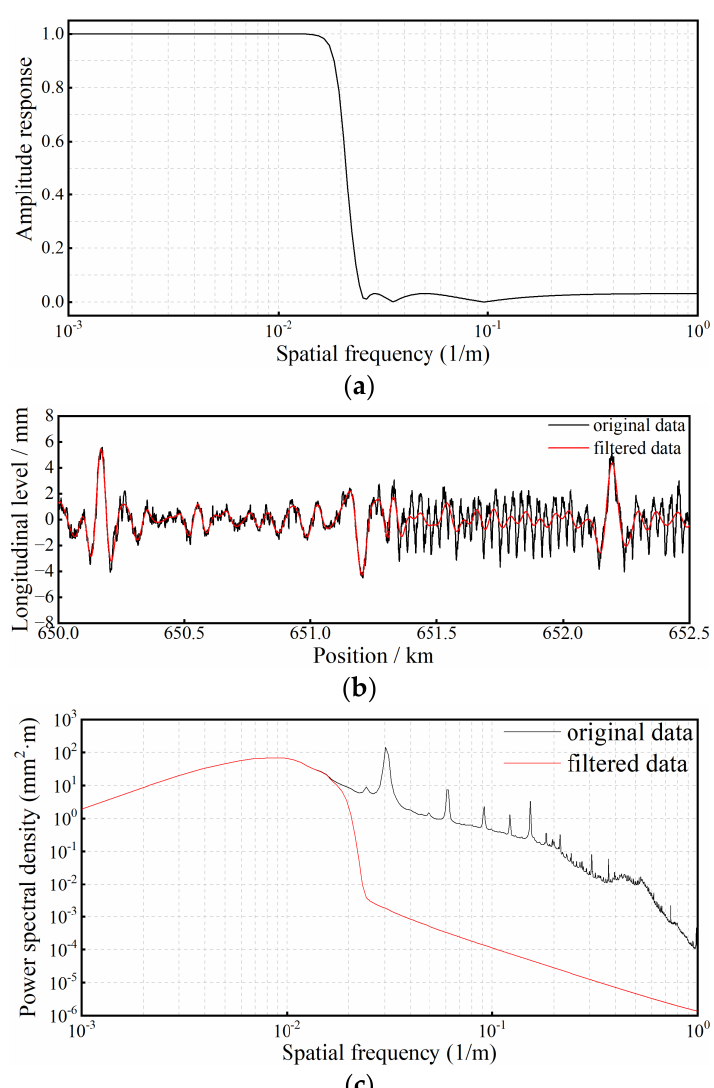
Figure 4. Characteristics and performance of the digital filter: ( a ) frequency response of the designed filter; ( b ) comparison of longitudinal-level waveforms before and after filtering; ( c ) comparison of power spectral density of longitudinal level before and after filtering.